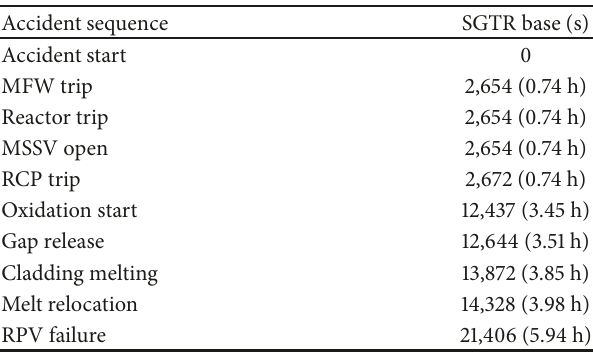
Table 2: Accident sequences in the base case.